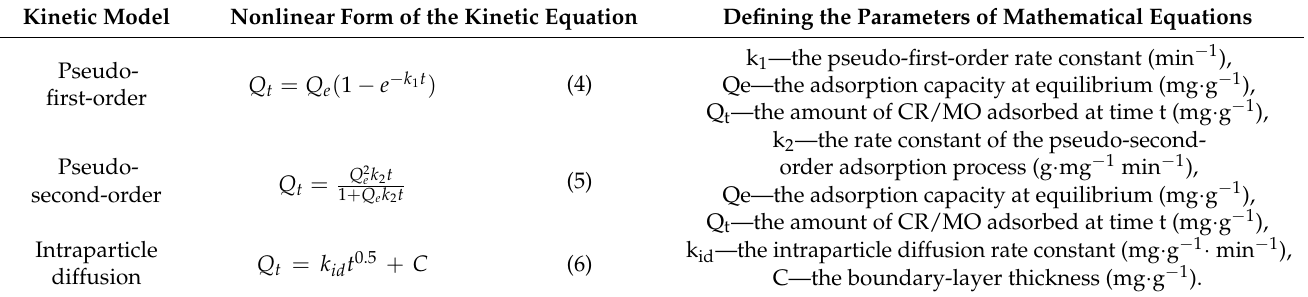
Figure 12. Effect of contact time on the adsorption capacity of CoFe 2 O 4 − 0, CoFe 2 O 4 − 0.1, CoFe 2 O 4 − 0.25, and CoFe 2 O 4 − 0.5 from single and binary solutions. Table 2. The kinetic models used to characterize the CR/MO adsorption onto CoFe 2 O 4 particles